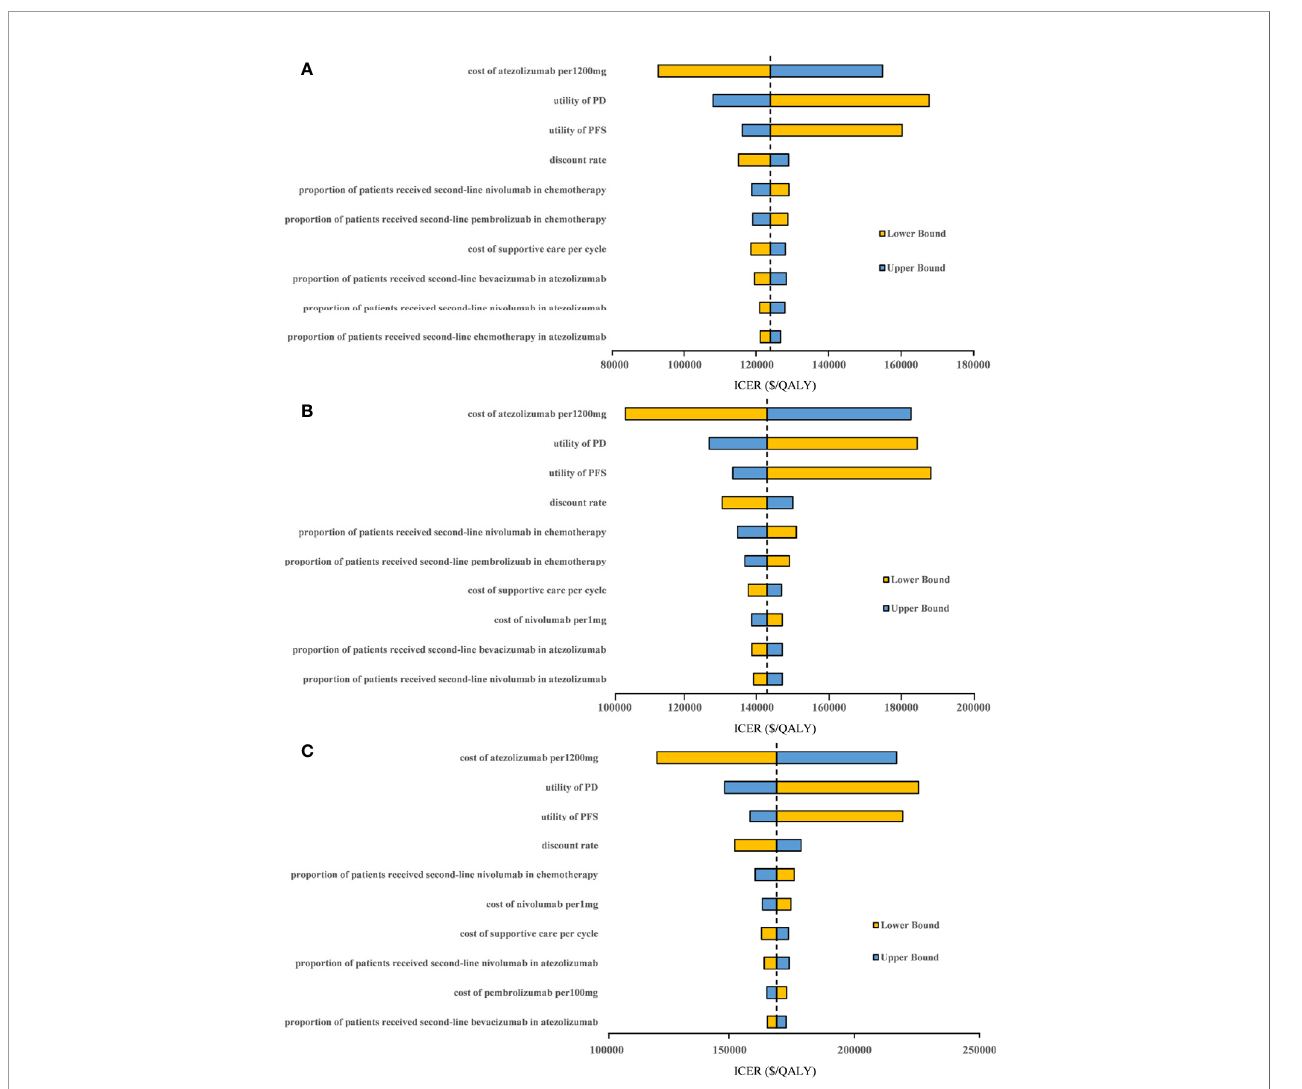
FIGURE 3 | Tornado diagram of one-way sensitivity analyses with greatest in fl uence parameters when the PAP was not available in (A) high PD-L1 expression populations, (B) high or intermediate PD-L1 expression populations and (C) any PD-L1 expression populations. PD-L1, programmed death ligand 1; PFS, progression-free survival; PD, progressed disease; ICER, incremental cost-effectiveness